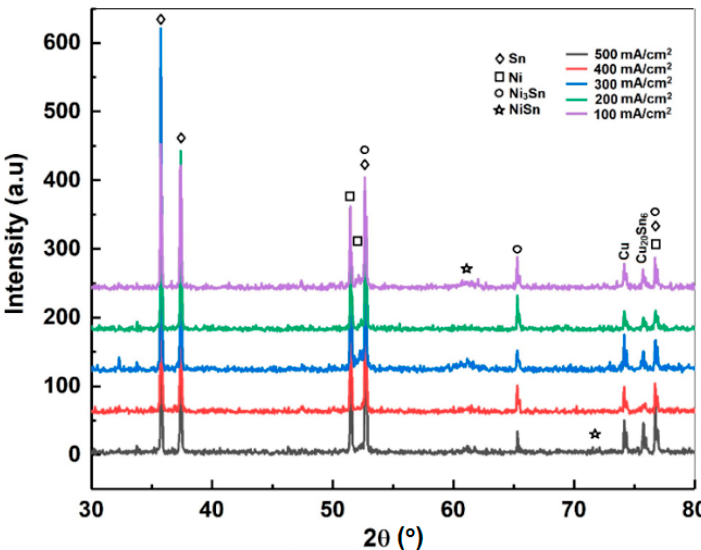
Coatings 2021 , 11 , x FOR PEER REVIEW Figure 3. XRD pattern of Ni–Sn coatings plated at various current densities. Figure 3. XRD pattern of Ni–Sn coatings plated at various current densities.